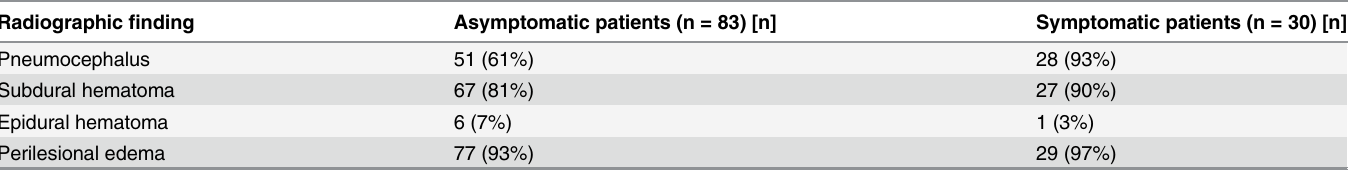
Table 2. Radiographic findings in postoperative imaging after meningioma surgery. Radiographic fi